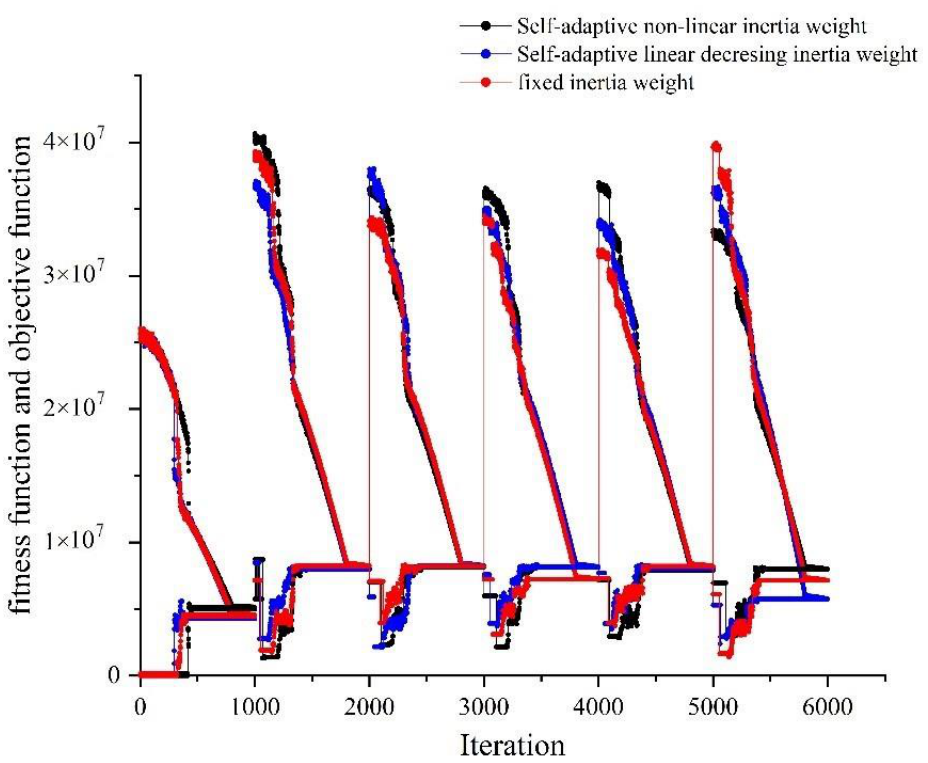
Figure 10. Convergence curve in the case of three inertia weight